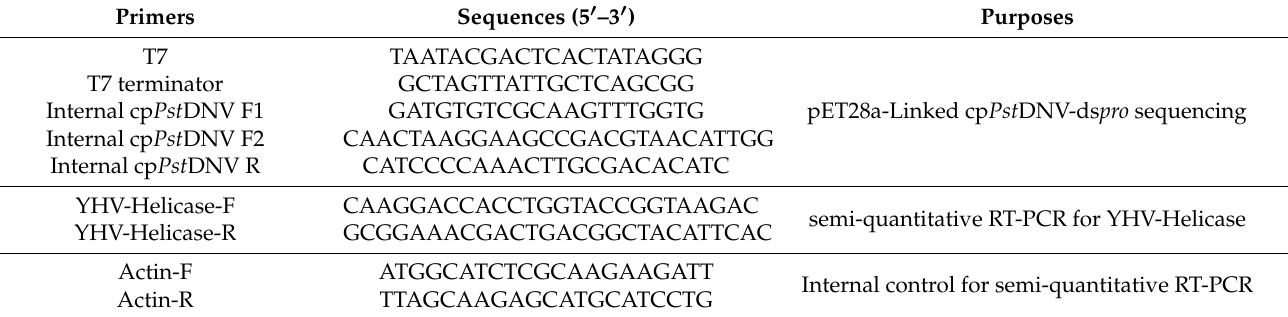
Table 1. Oligonucleotides used this